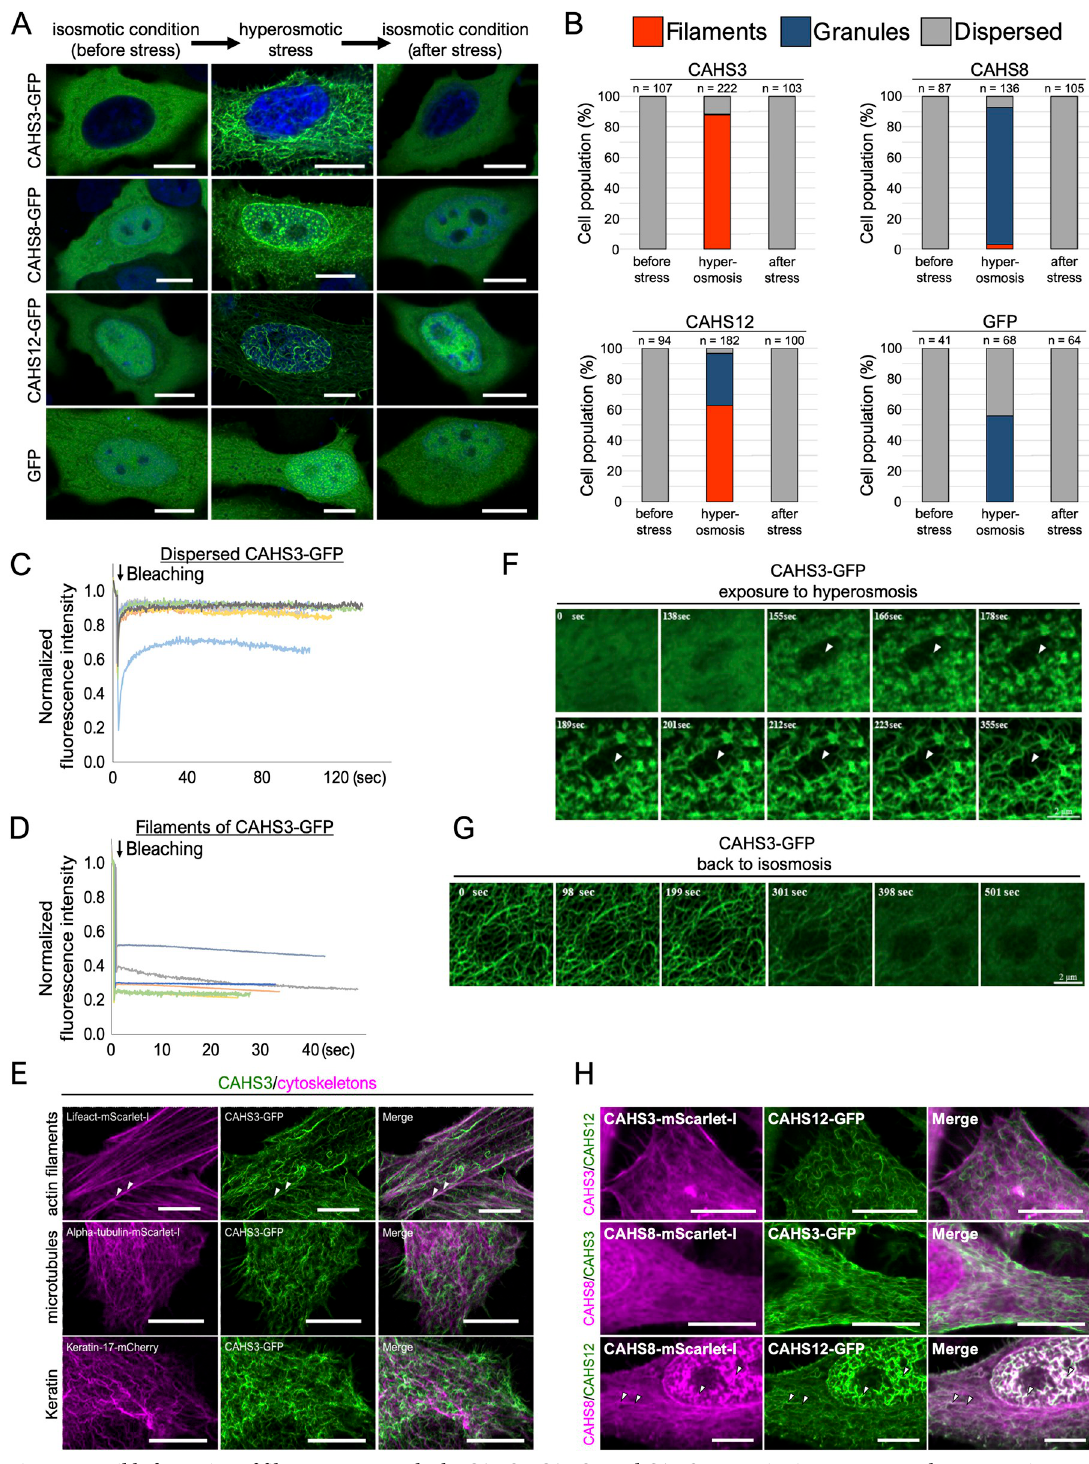
Fig 2. Reversible formation of filaments or granules by CAHS3, CAHS8, and CAHS12 proteins in response to a hyperosmotic stress. (A) Distribution changes in AcGFP1-tagged CAHS3, CAHS8, or CAHS12 proteins in HEp-2 cells during the transient hyperosmotic treatment with HBSS containing 0.4 M trehalose. Blue indicates Hoechst33342 staining of nuclei. (B) The proportion of distribution patterns (filaments, granules, or dispersed) of each CAHS protein in human cells. (C and D) FRAP analyses of CAHS3-GFP in human cells in dispersed state under an isosmotic condition (C, n = 7) and in a filament-formed state under a hyperosmotic condition